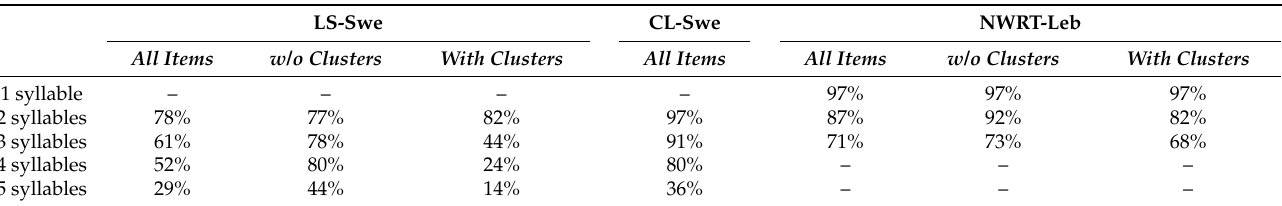
Figure 2. Accuracy (% correct responses) for items in LS-Swe and NWRT-Leb by number of syllables and presence of consonant clusters.